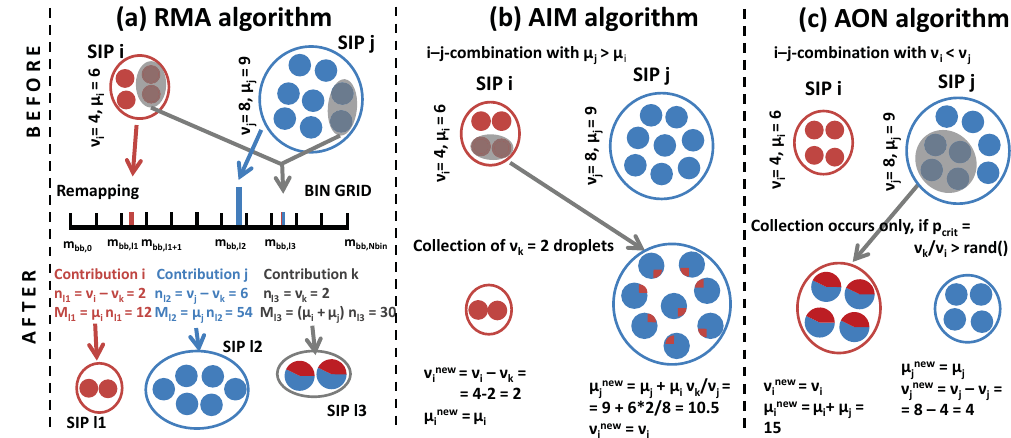
Figure 2. Treatment of a collection between two SIPs in the remapping algorithm (RMA), average impact algorithm (AIM) and all-or-nothing algorithm